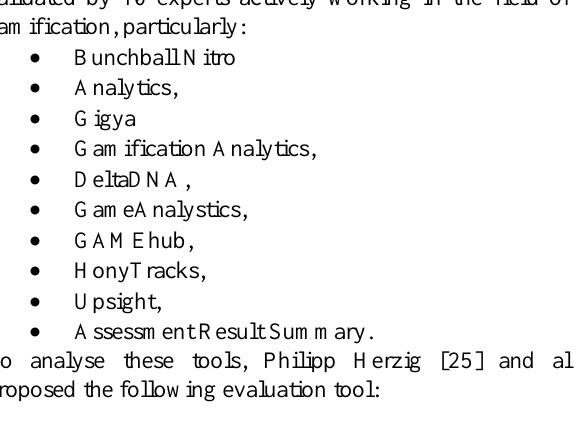
Table 1. Gamification Measurement Product